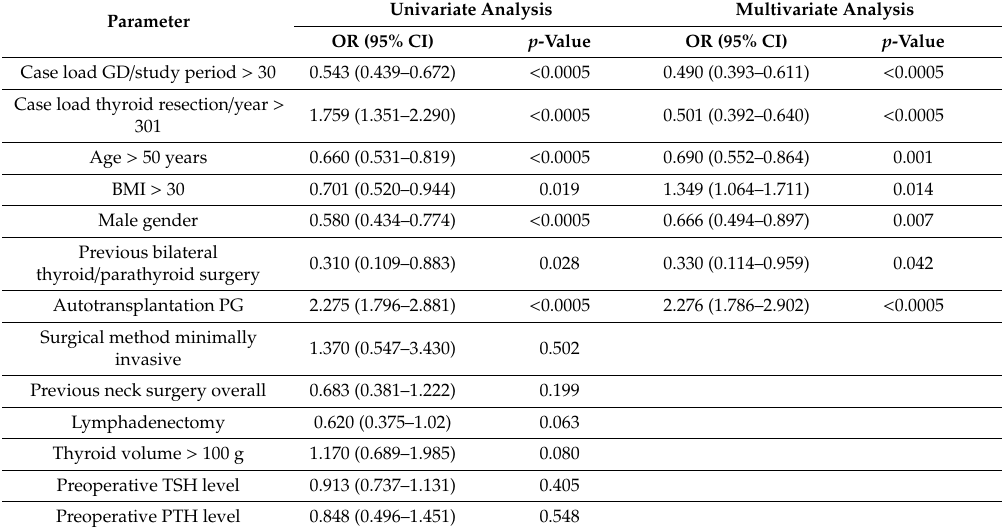
Table 6. Uni- and multivariate logistic regression of parameters associated with postoperative temporary